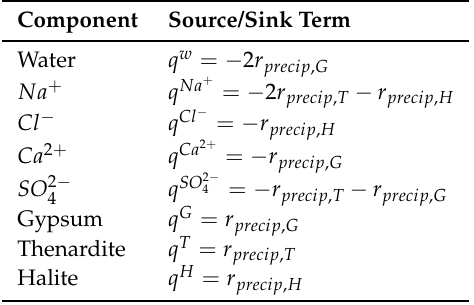
Table 3. Source/sink terms of the transport equations of each component.